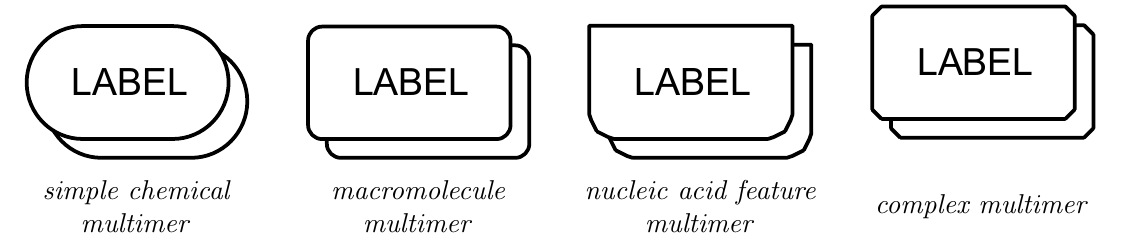
Table 2.8: The Process Description glyphs for the different types of multimers